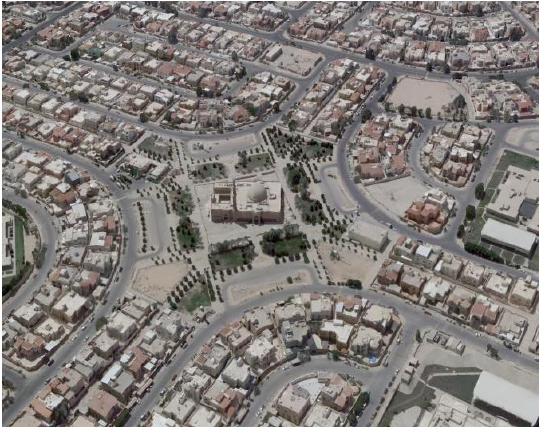
Figure 7. A 3D model of Dammam city. Model Obtained from Aerial and Oblique Imagery The results derived for 3D city model using aerial imagery and oblique imagery delineate drastic changes in the output results both in texture and shape of the features.